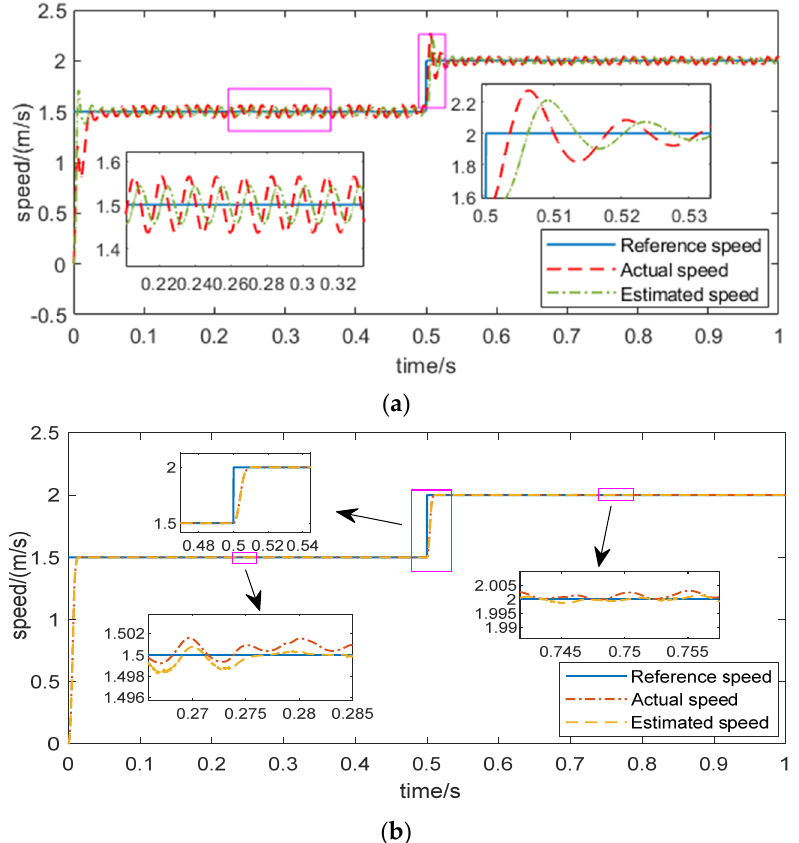
Figure 8. Comparison of observation effects of observers: ( a ) waveform of observed velocity and actual velocity of conventional SMO system; ( b ) waveform of observed velocity and actual velocity of THE F-ST-SMO system.